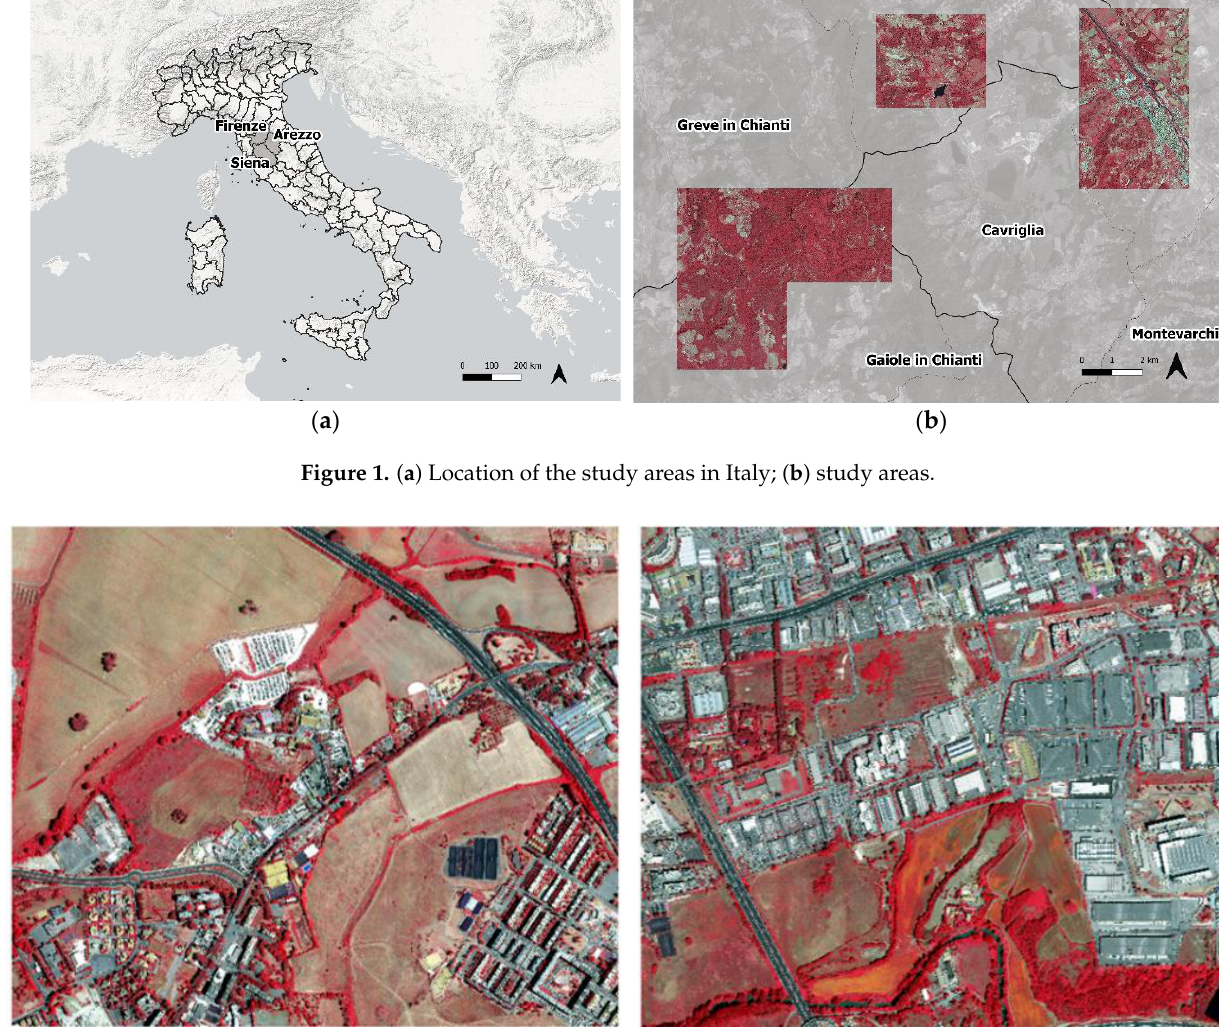
Figure 2. ( a ) Training area; ( b ) validation area.